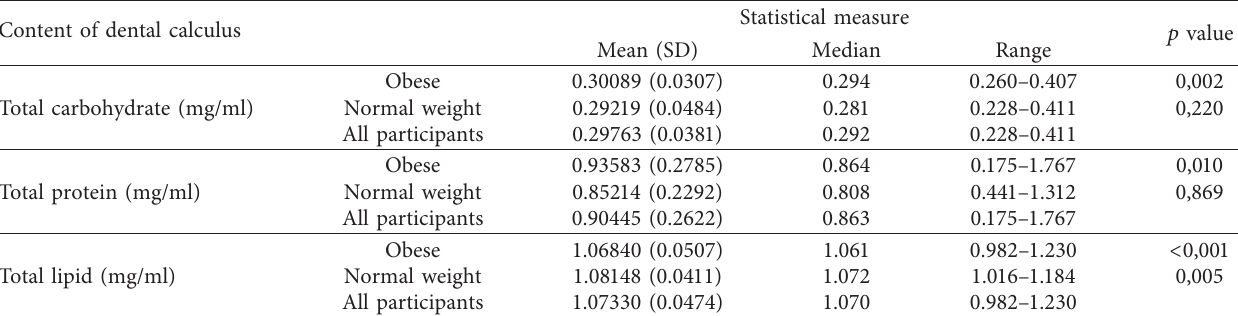
Table 3: Descriptive statistics of the macronutrient content of dental calculus of both obese and normal-weight individuals.